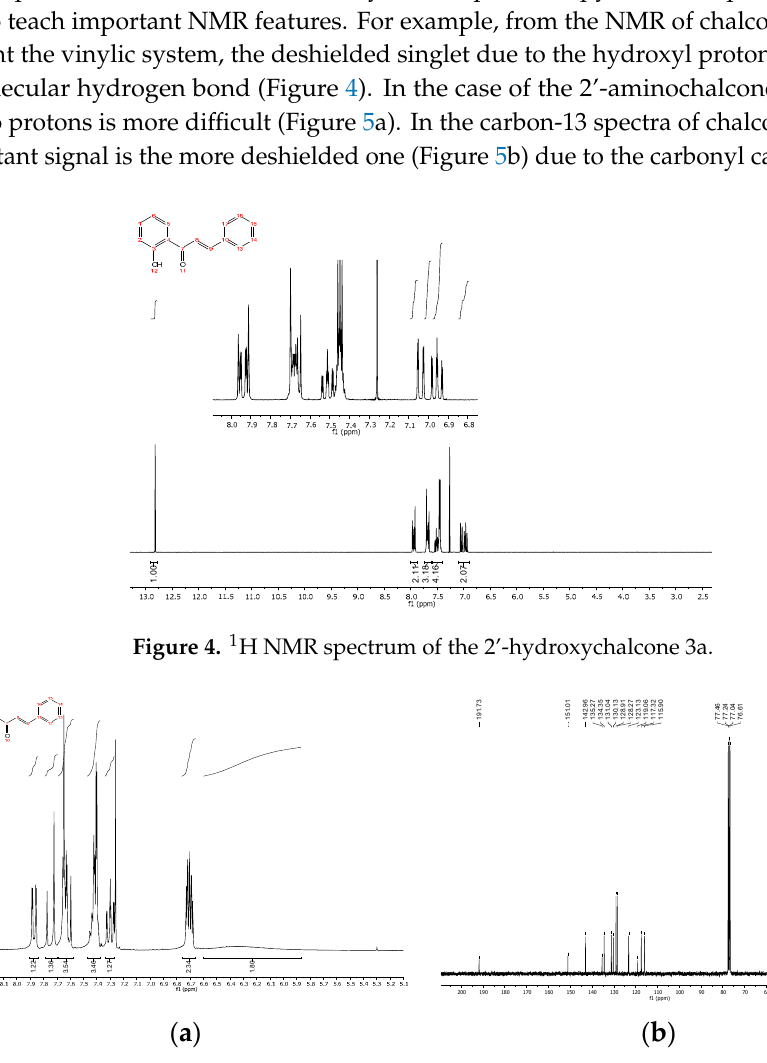
Figure 5. ( a ) 1 H NMR spectrum of the 2’-aminochalcone 3d; ( b ) 13 C NMR spectrum of the 2’-aminochalcone 3d.